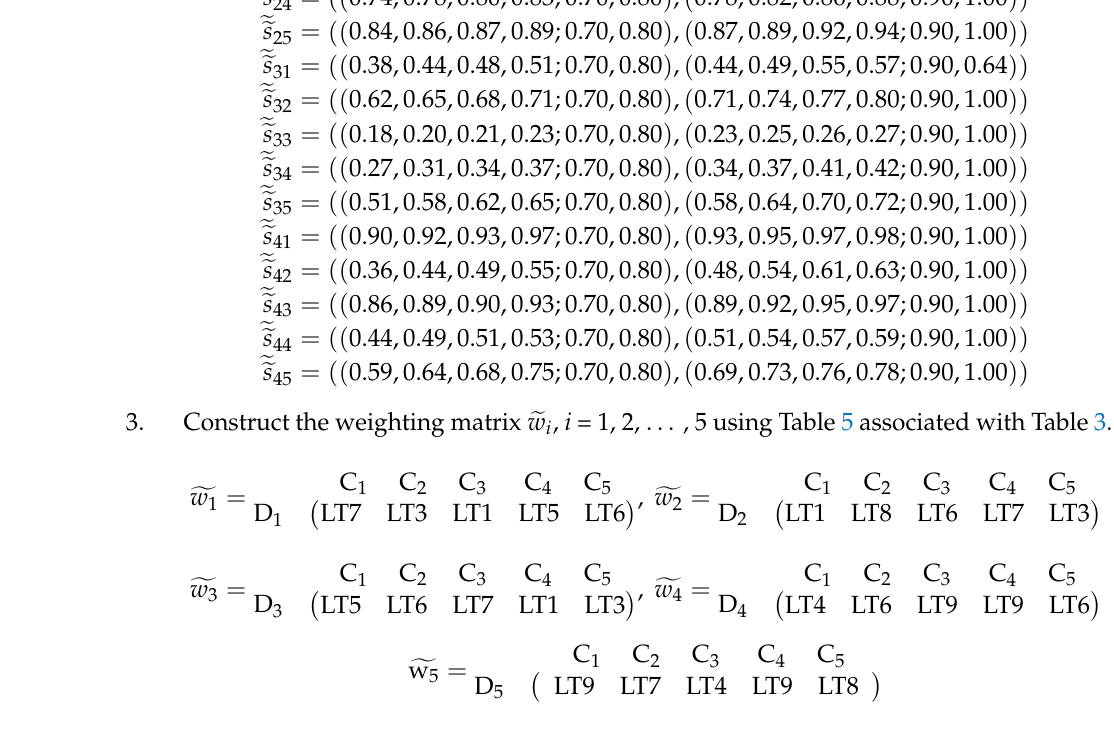
Table 5. Social factors preference performance matrix employing linguistic terms, based on decision- maker